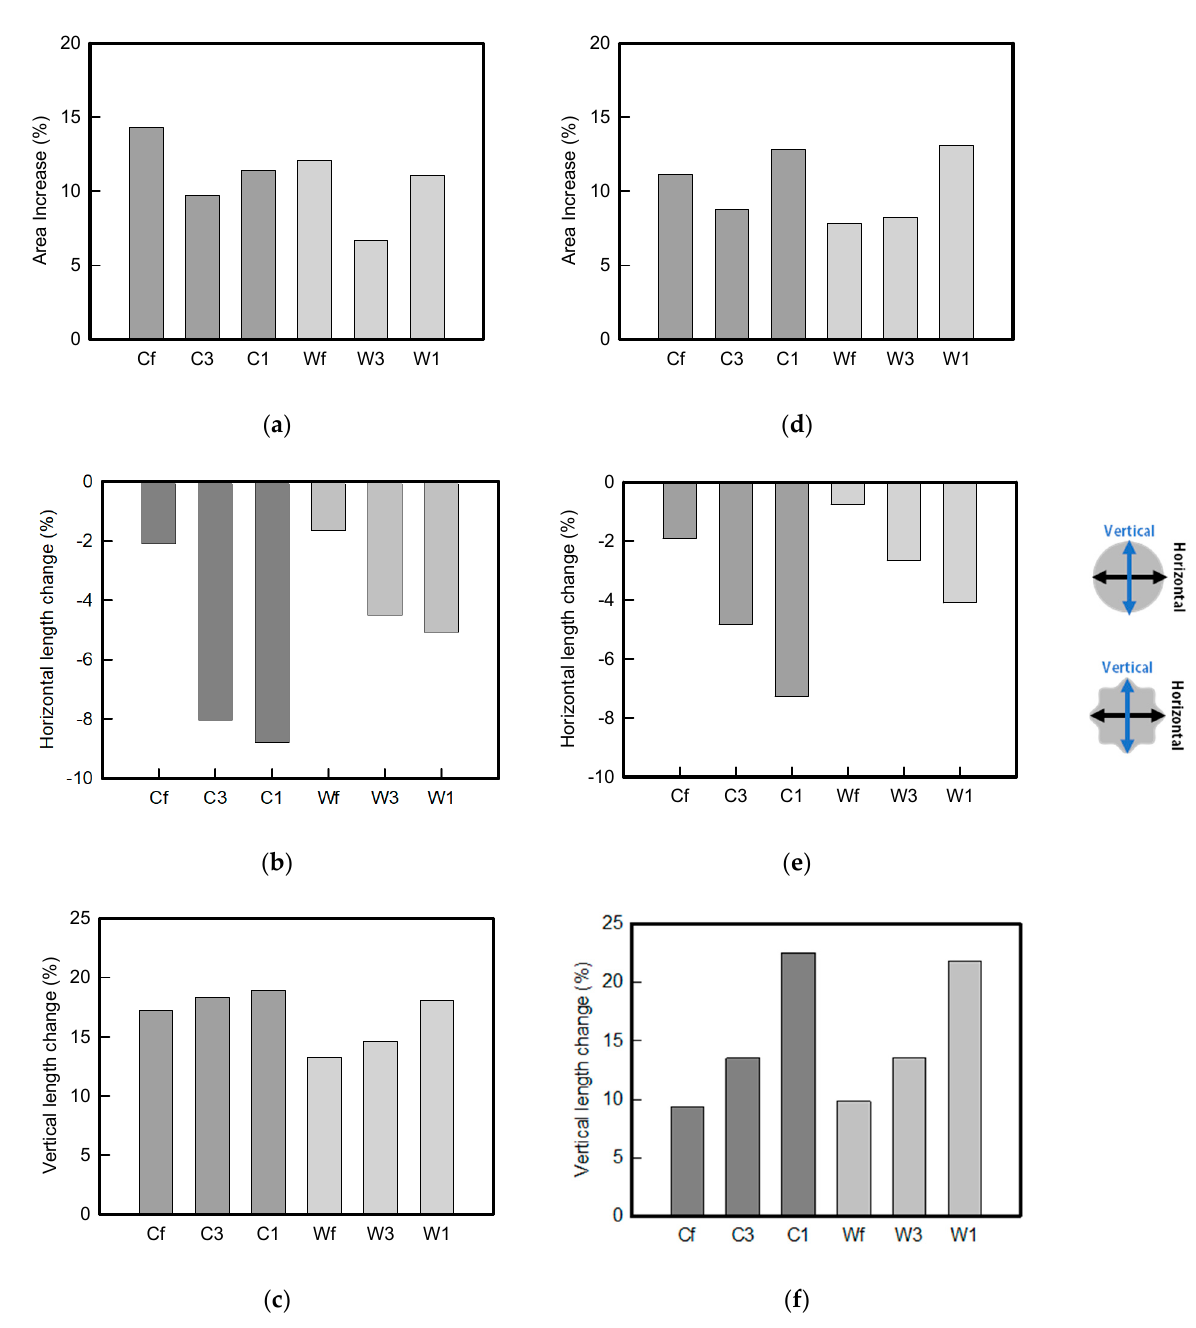
Figure 6. DIC system analysis results of circle- and wave-type embroidery-based textile electrodes for elongation at 30%; ( a ) area increase; ( b ) horizontal length change; ( c ) vertical length change in a single electrode; ( d ) area increase; ( e ) horizontal length change; ( f ) vertical length change of a bipolar electrode.